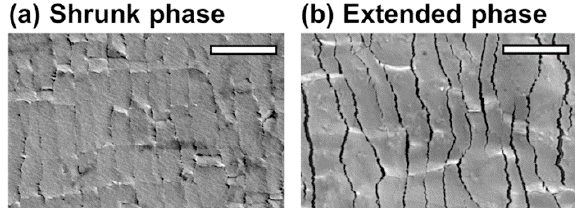
Figure 5. High-resolution scanning electron microscopy image of the cracks in the platinum (Pt) layer during ( a ) shrunk phase and ( b ) extended phase (5% strain) (Scale bar: 3 m).